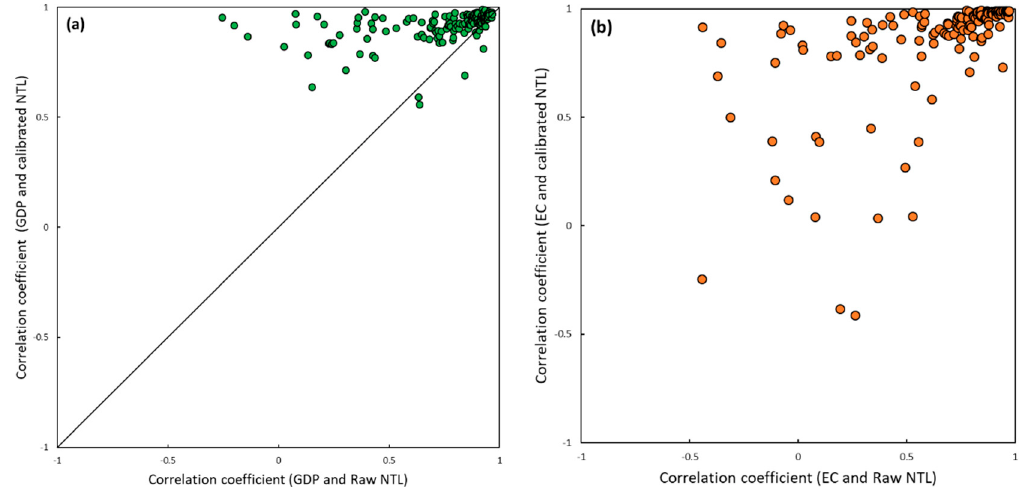
Figure 2. The correlation of GDP ( a ) and EC ( b ) with the raw NTL and the calibrated NTL. The black line is the 1:1